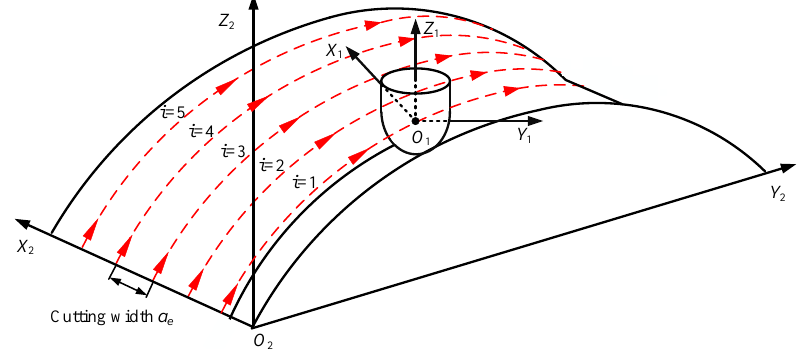
Figure 3. Schematic diagram of tool path for the milling convex surface.